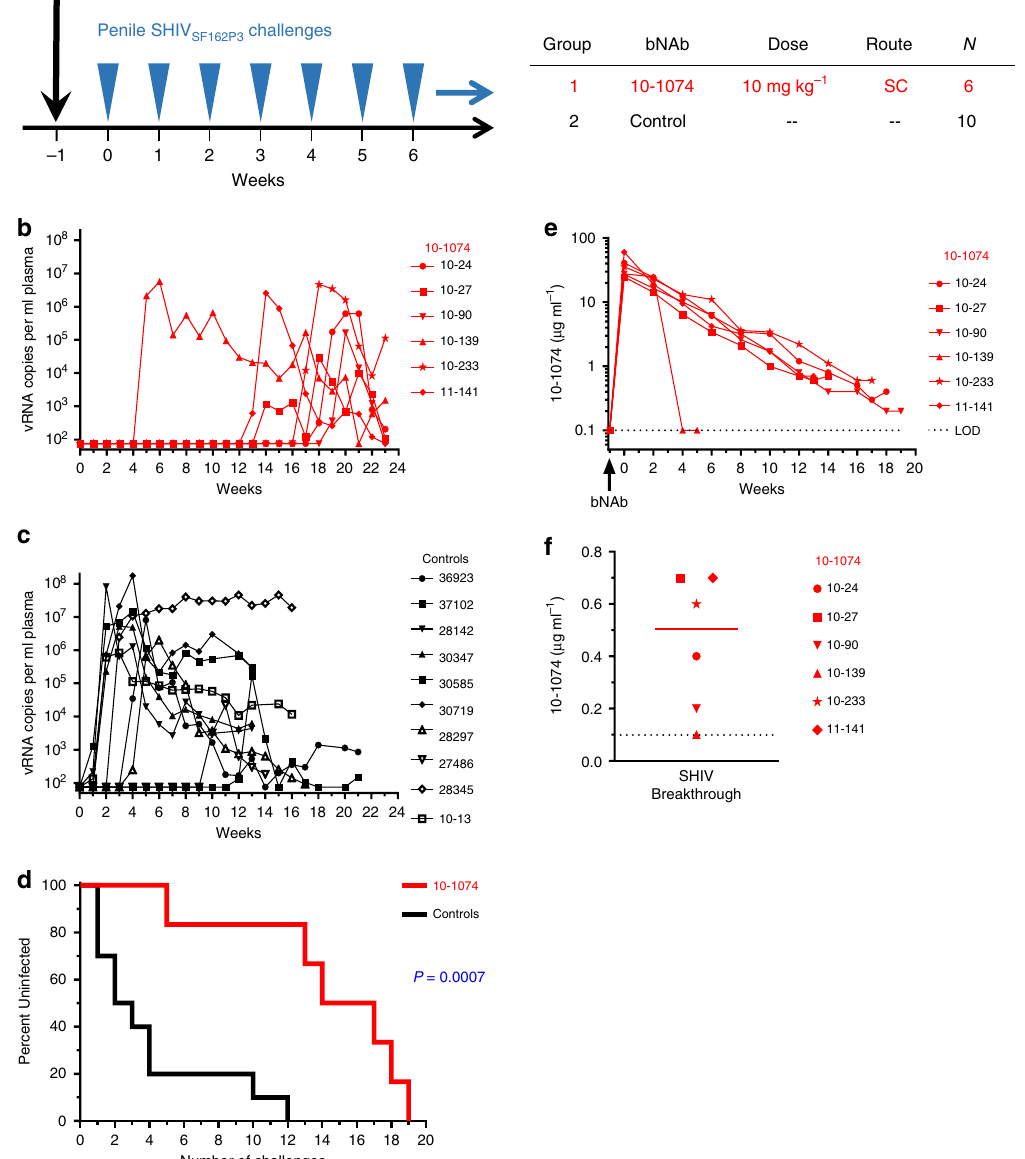
Fig. 1 Passive immunization of macaques with bNAb 10 – 1074 delays SHIV acquisition following repeated penile SHIV challenges. a Study design to assess the protective ef fi cacy of 10 – 1074 against repeated penile SHIV challenges. Rhesus macaques ( N = 6; Indian origin) were injected subcutaneously once with 10 – 1074 (10 mg kg − 1 ). Beginning 1 week later, macaques were challenged repeatedly, once per week, via the penis with SHIV SF162P3 (200 TCID 50 into the prepuce pouch and 16 TCID 50 into the distal urethra) until systemic SHIV infection was con fi rmed via plasma viral load assay. Control macaques ( N = 10) received no antibody, but were challenged identically. Plasma viral load (vRNA copies ml − 1 ) determined in 10 – 1074-treated macaques ( b ) or untreated controls ( c ). Symbols denote individual animals. d Percentages of macaques remaining uninfected at 7 days following administration of the indicated cumulative number of SHIV challenges. Statistical difference between groups was measured using a two-sided log-rank test ( P = 0.0007). e Plasma levels of 10 – 1074 ( μ g ml − 1 ) were determined via TZM-bl neutralization assays using 10 – 1074-sensitive pseudovirus X2088.c9. f Plasma concentrations of 10 – 1074 in individual macaques ( N = 6) at the time of SHIV breakthrough (values from e ).The solid line denotes the group median; the dotted line denotes the limit of detection for 10 – 1074. Source data are provided in Supplementary Tables or a Source data fi le. SHIV infection data for animals in the control group have been reported previously in a paper describing the development of our penile SHIV infection model 33 and are reproduced here to facilitate comparison between the treatment and control (Fig. 1a). We performed nontraumatic penile challenges with macaques received 200 TCID 50 SHIV SF162P3 into the prepuce SHIV using a ‘ no contact ’ technique that eliminated inadvertent pouch and 16 TCID 50 SHIV SF162P3 into the distal urethra. Ten historical control animals (Group-2) had received no antibodies perturbation of the penile mucosa during the inoculation proce- and had been challenged identically with the same stock of dure itself, while simultaneously exposing multiple susceptible SHIV SF162P3 (Fig. 1a). Penile SHIV SF162P3 challenges were penile tissues to the challenge virus 33 . For each virus challenge,